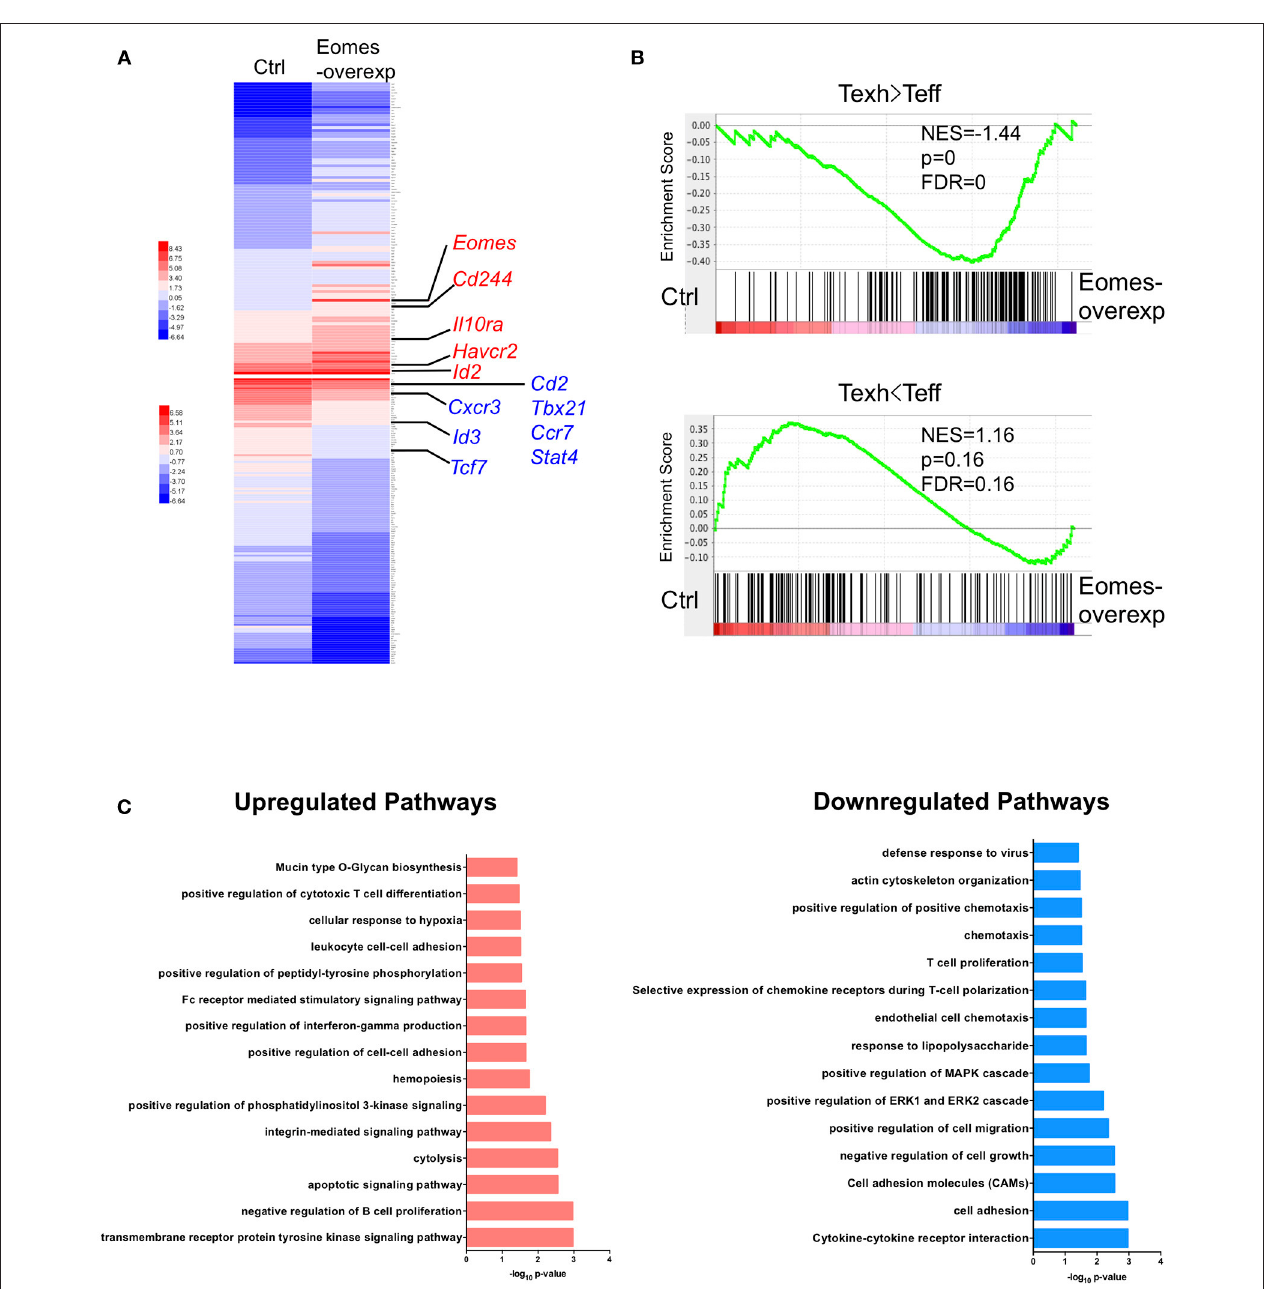
FIGURE 4 | Eomes establishes the exhaustion-associated transcriptional profile. (A) Heatmap of the top 100 up-regulated and down-regulated differentially expressed genes (DEGs) in Eomes-overexpressing vs. control OT-I cells. Genes important for Th1 differentiation and memory development as well as for T cell exhaustion are highlighted. See also Table S1 . (B) Gene set enrichment analysis (GSEA) of genes up-regulated and down-regulated in exhausted CD8 + T cells (Day 30) compared to effector CD8 + T cells (Day 15) in chronic LCMV infection (30). (C) Pathway analysis of up-regulated and down-regulated DEGs using